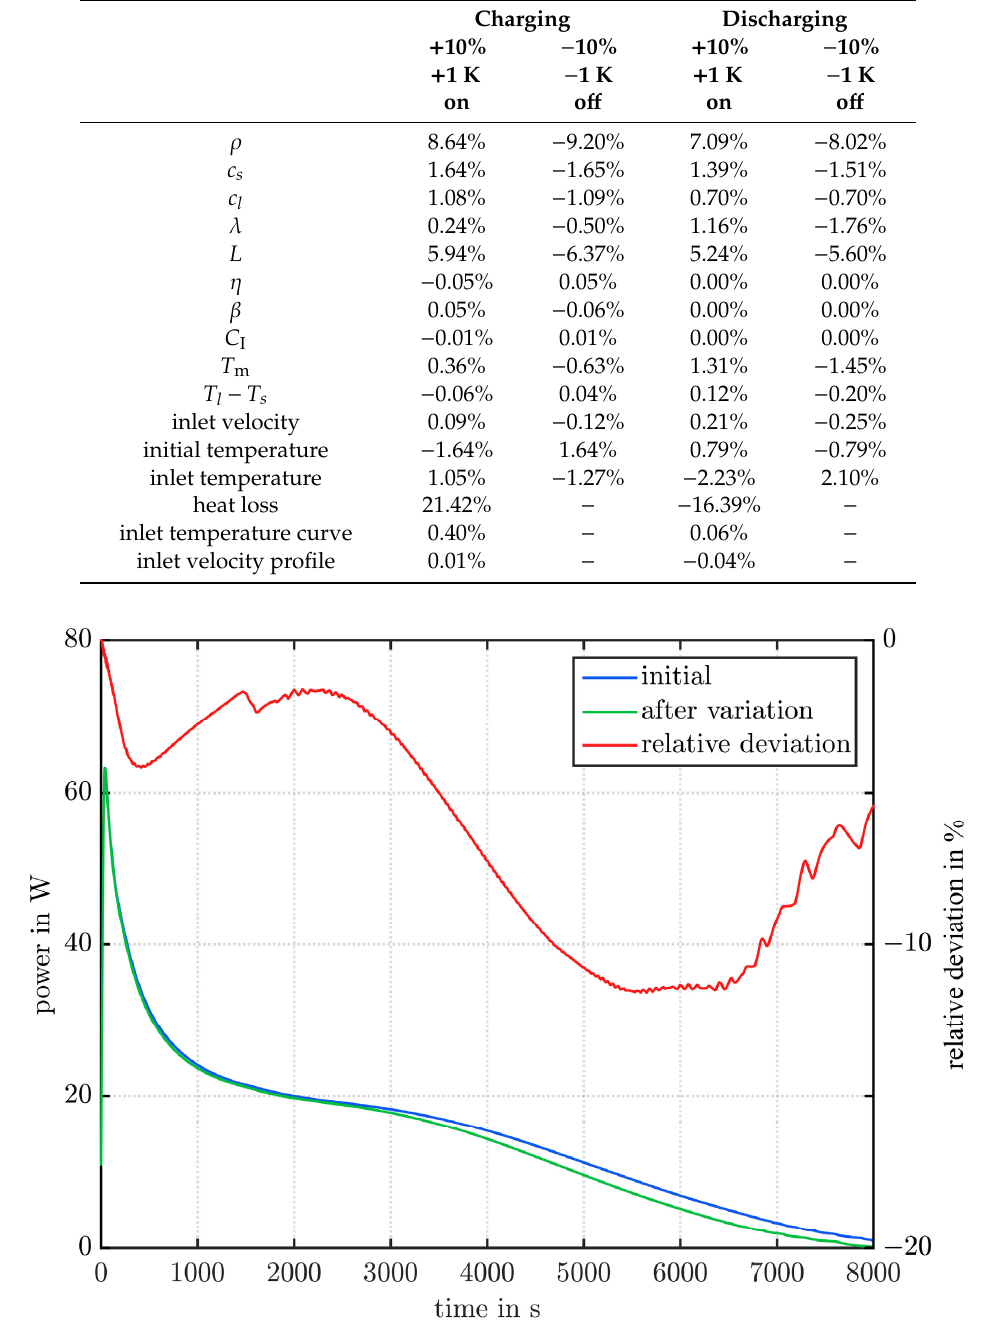
Figure A2. Power over time curve for charging of the standard case and the case with a decreased heat conductivity as well as the regarding relative deviation.